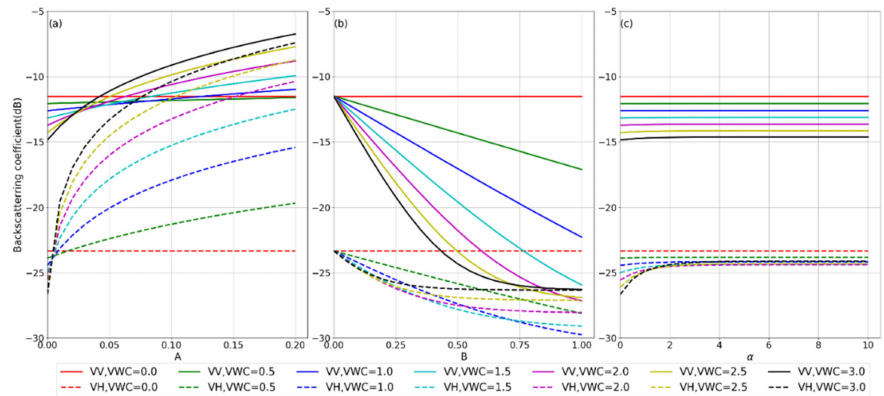
Figure 3. Response of backscatters at C-band (frequency = 5.405) with incidence angle of 40 ◦ to the variation of empirical parameters A ( a ), B ( b ), α ( c ) of the WCM. The solid and dashed lines represent VV-and VH-polarized backscatters, respectively, while the line colors represent di ff erent VWC